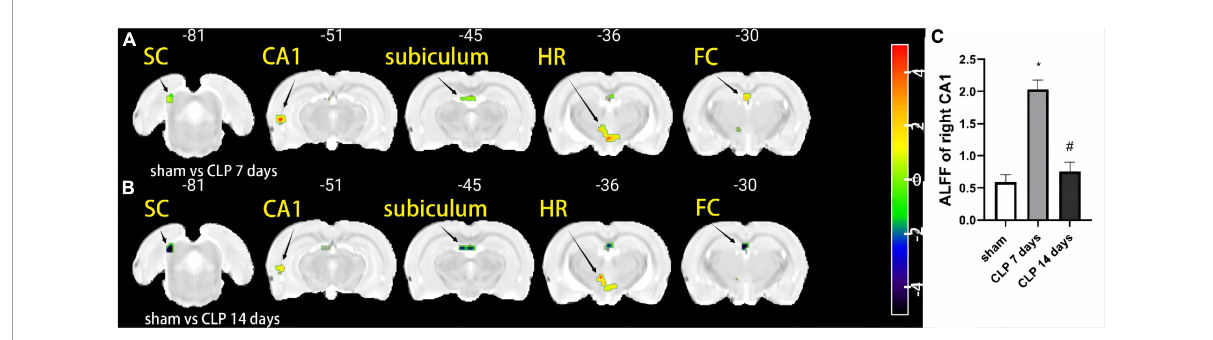
FIGURE1 The amplitude of low-frequency fluctuation (ALFF) differences in the day 7 post cecal ligation and perforation (CLP), and day 14 post CLP groups. Warm (red-yellow) colors represent increased and cold (blue-green) colors decreased ALFF values in the day 7 post CLP, and day 14 post CLP groups. (A) ALFF values were higher in the right CA-1, left FC, and HR in the day 7 post CLP group. (B) The left FC, right deep layers of the SC, CA-1, and subiculum showed lower ALFF in the day 14 post CLP group ( n = 8 in each group. FDR corrected p < 0.005, cluster size > 10 voxels). (C) The ALFF value of right CA-1 was significantly higher in the day 7 post CLP group than sham group, but lower in day 14 post group ( n = 8, * p < 0.05, compared with sham group, # p < 0.05, compared with day 7 post CLP group, analyzed by one-way ANOVA). CA-1: Cornu ammonis-1; SC: deep layers of the superior colliculus; FC: fasciola cinereum; HR: hypothalamic region.